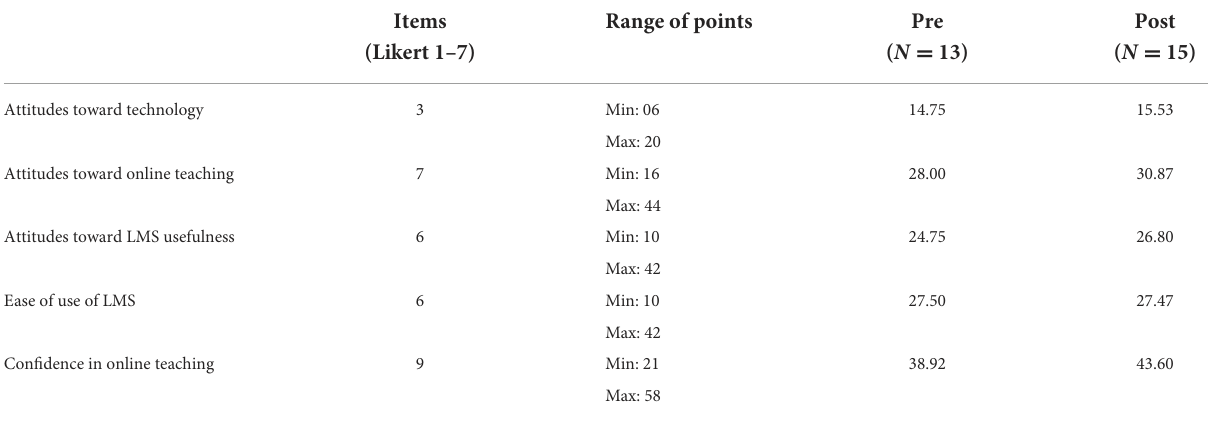
TABLE 1 Mean scores on pre and post attitudinal